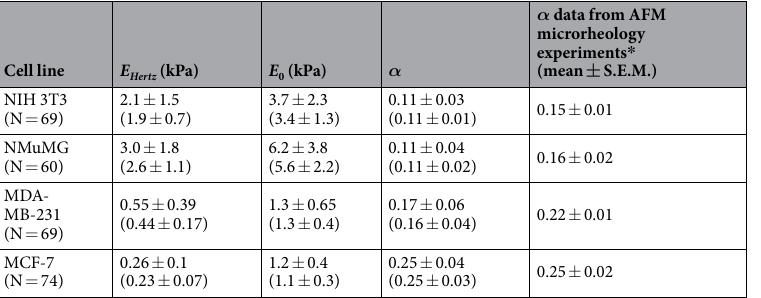
Table 1. Viscoelastic parameters of studied cell lines. Mean ± s.d. (median ± m.a.d.). N is the number of measured cells. All cell lines were at 60–80% confluence during the experiment. * Data from ref.